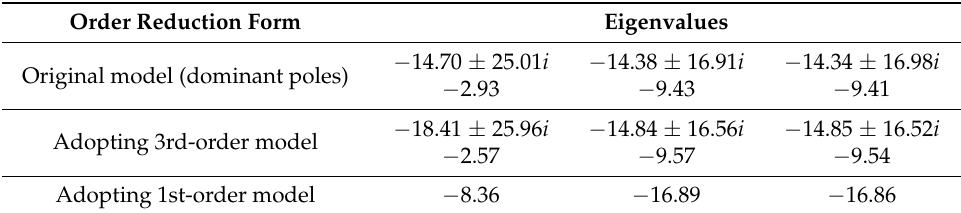
Table 7. Dominant eigenvalues of test system 2 order reduction at stable point.